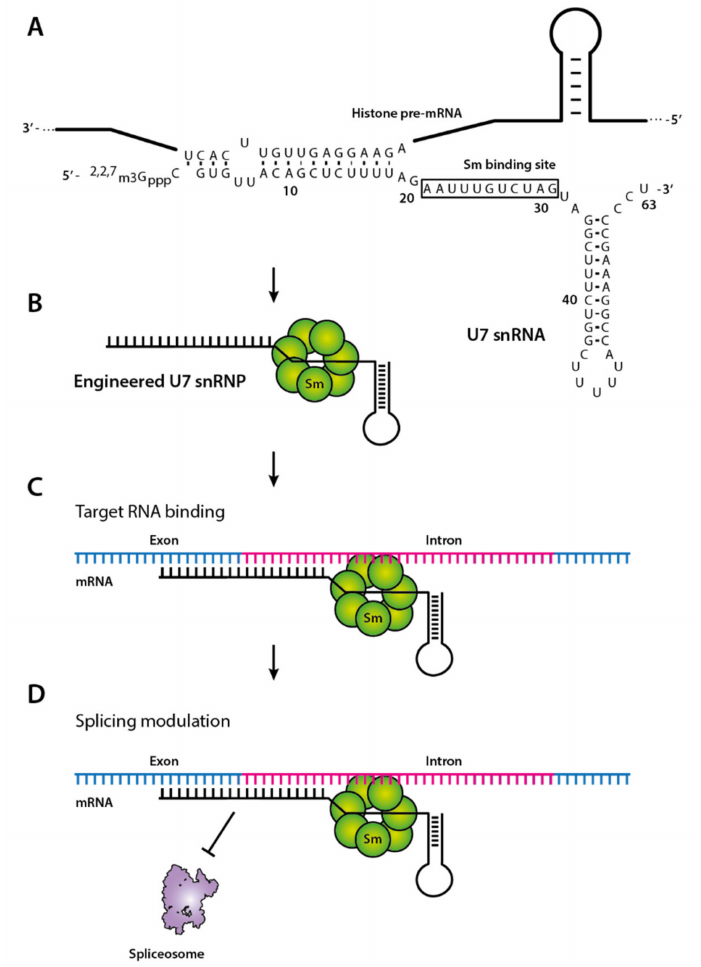
Figure 2. Modified U7 snRNP involved in splicing correction. ( A ) Sequence of U7 snRNA and histone pre-mRNA. The Sm binding site is indicated with a box. ( B ) Engineered U7 snRNA contains an optimized Sm, which is involved in splicing, resulting in binding of the spliceosomal Sm core proteins. The sequence of U7 snRNA, complementary to the histone downstream element, can be altered to the desired antisense sequence of the target gene. ( C ) The engineered U7 snRNP binds its target sequence by canonical base pairing and results in ( D ) modulation of the splicing due to steric blocking of the snRNP bound to the exon-intron